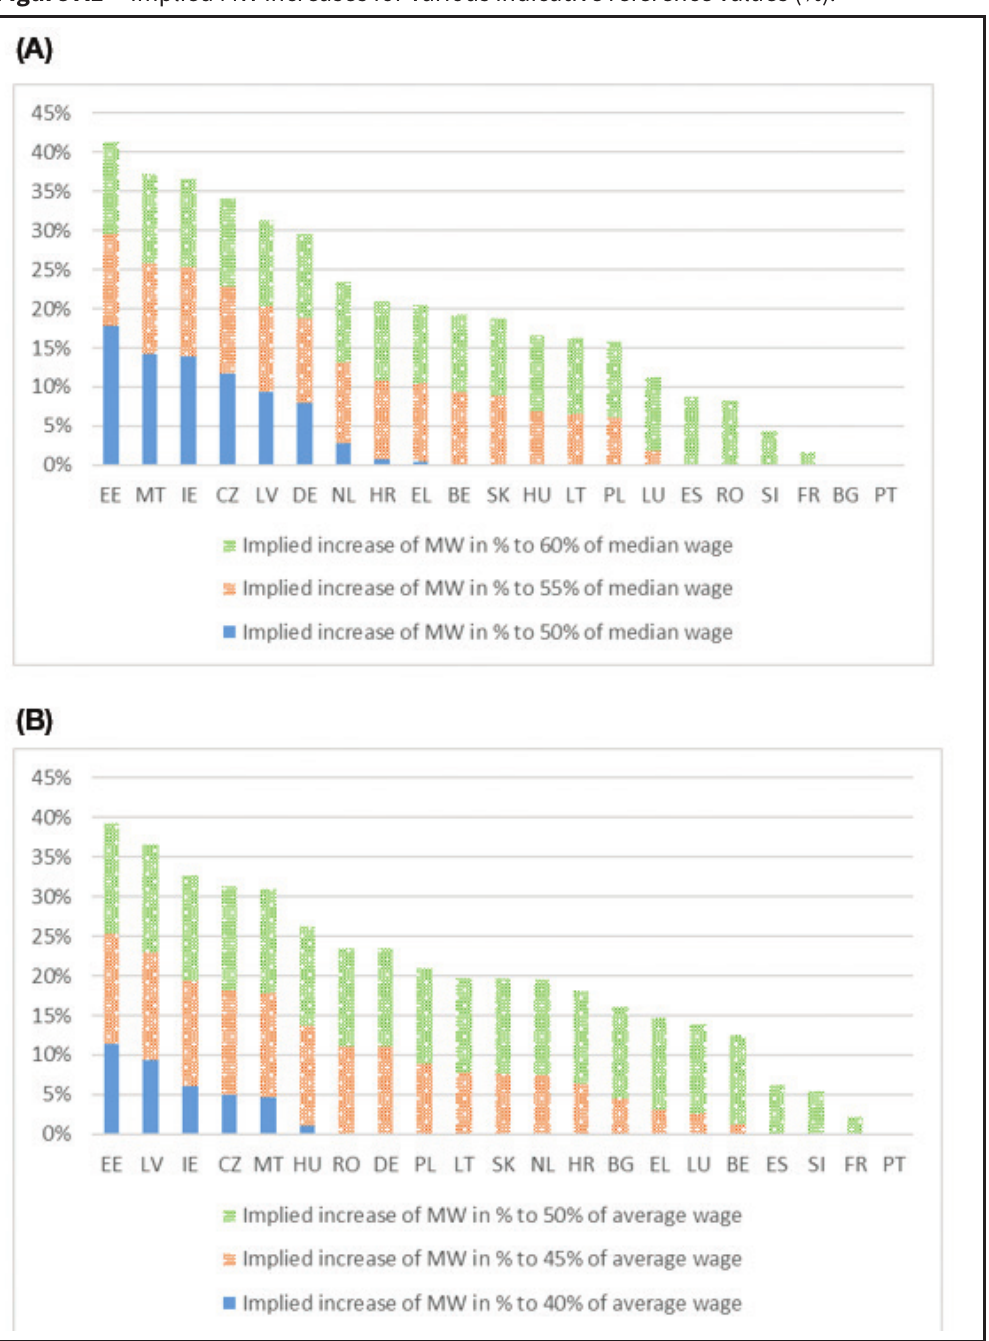
Implied MW increases for various indicative reference values